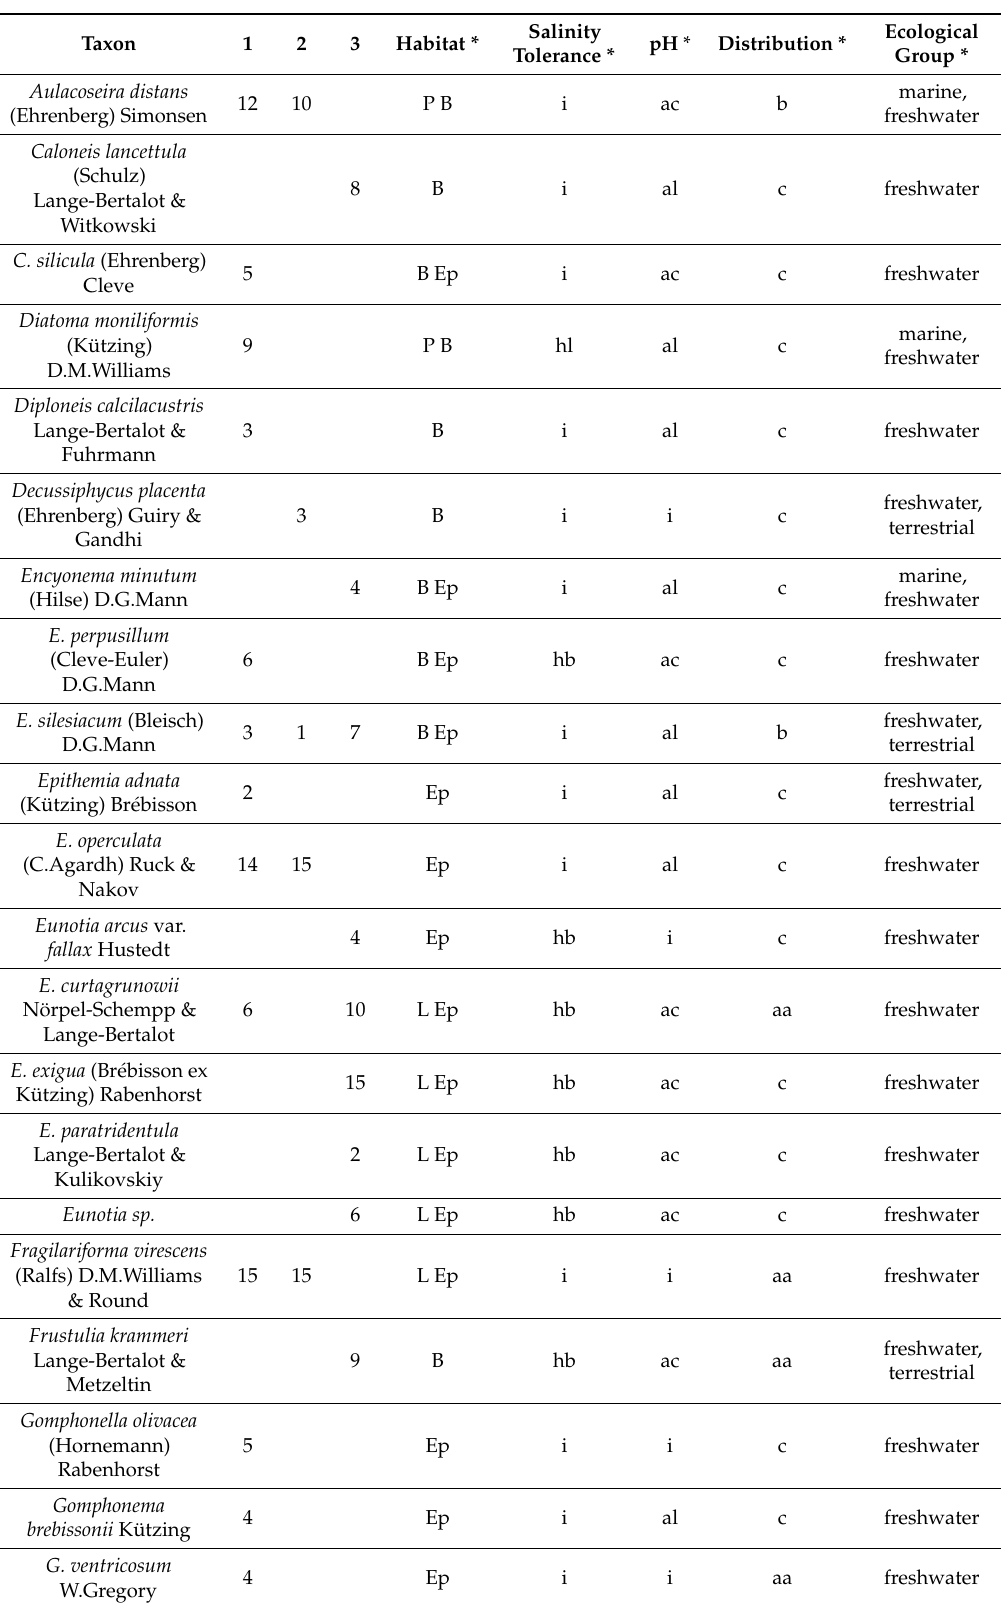
Table 3. List of diatom taxa with the relative abundance and ecological preferences * [40–47] in the Malki Upper Paratunka and Dachnie thermal